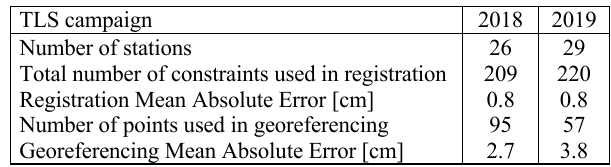
Table 2 . Parameters of TLS data registration and